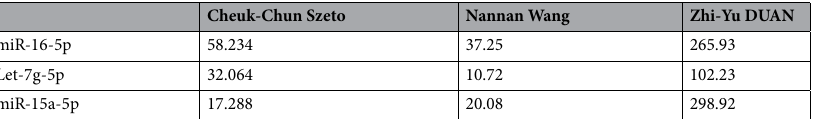
Table 2. Fold change analysis of miR-16-5p, Let-7g-5p, miR-15a-5p from three miRNA profiles. Fold change: IgAN group/normal controls.